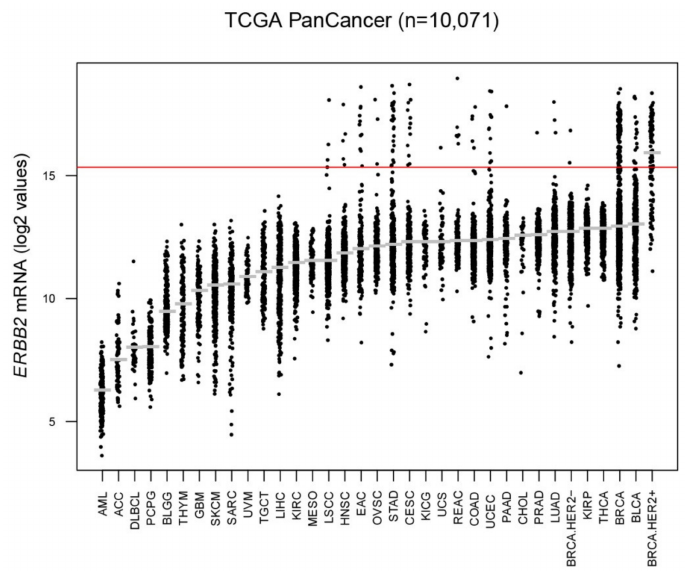
Figure 5. ERBB2 mRNA expression across cancer types. Distribution of ERBB2 mRNA levels across cancer-types TCGA datasets. The ERBB2 mRNA cuto ff is shown as a red line. Abbreviations are shown in Table